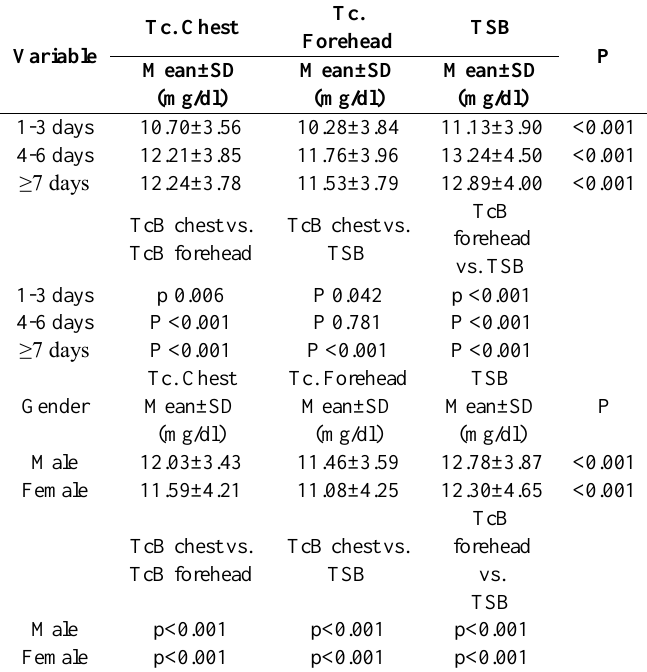
Table (7): Distribution of bilirubin levels according to technique for different age groups and gender